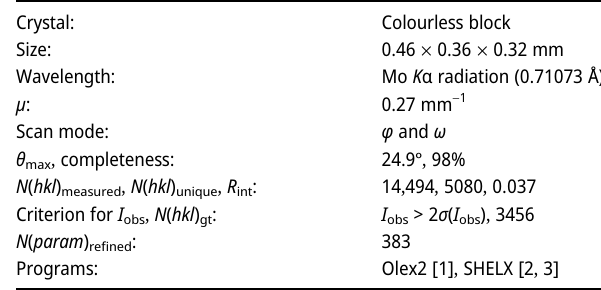
Table  : Data collection and